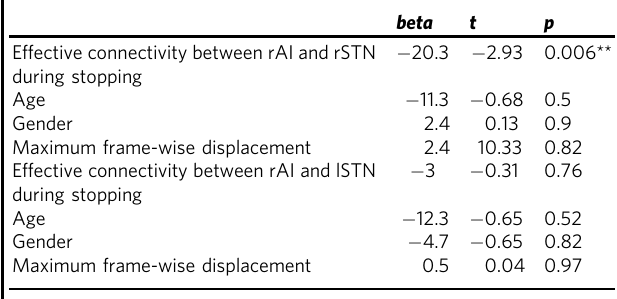
Table 4 Linear regression shows that rAI – rSTN